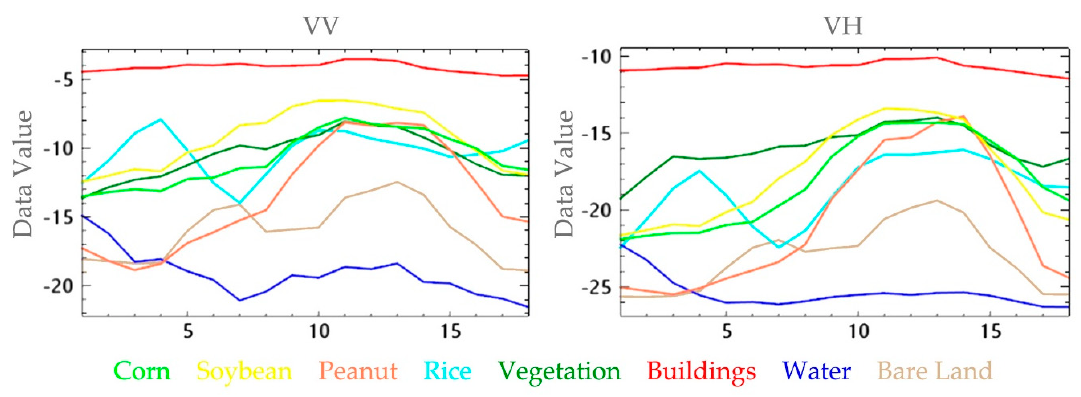
Figure 5. Time series curve analysis of different ground objects.